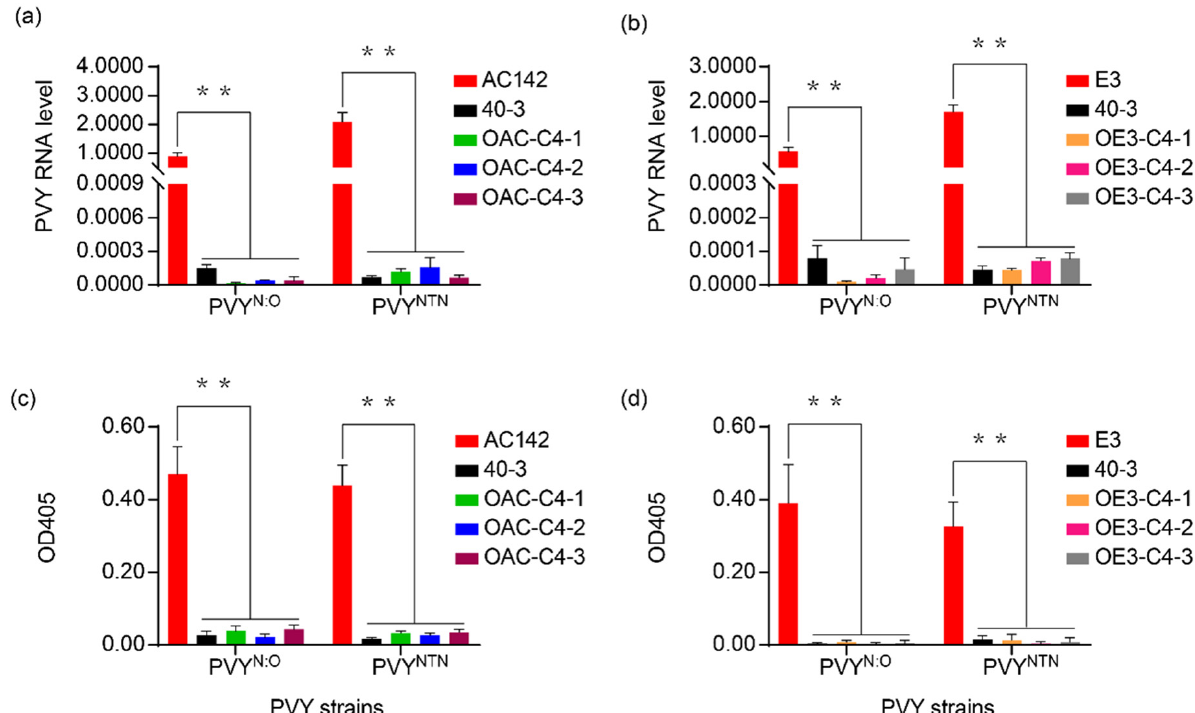
Figure 5. Phenotyping of extreme resistance in transgenic lines derive from AC142 and E3. ( a ) PVY RNA levels in the non-inoculated leaves of transgenic lines derived from AC142 and harboring C4. RNA levels were quantified two weeks after inoculation with PVY N:O and PVY NTN . The 40-3 indicates S. chacoense accession 40-3, the resistant parent; ( b ) PVY RNA levels in the non-inoculated leaves of transgenic lines. RNA levels were quantified two weeks after inoculation with PVY O -FL, PVY N:O and PVY NTN ; ( c ) Titers of PVY N:O and PVY NTN in transgenic lines derived from AC142 and harboring C4. Titers were determined using ELISAs four weeks after inoculation; ( d ) Titers of PVY O , PVY N:O and PVY NTN in transgenic lines derived from E3 and harboring C4. Titers were determined using ELISAs four weeks after inoculation. The 40-3 indicates S. chacoense accession 40-3, the resistant parent. Data in ( a ) and ( c ) are presented as mean values ± SE. ** indicates a statistically significant difference ( p < 0.01) compared to AC142 as determined using a Student’s t -test. Data in ( b ) and ( d ) are presented as mean values ± SE. ** indicates a statistically significant difference ( p < 0.01) compared to E3 as determined using a Student’s t -test.